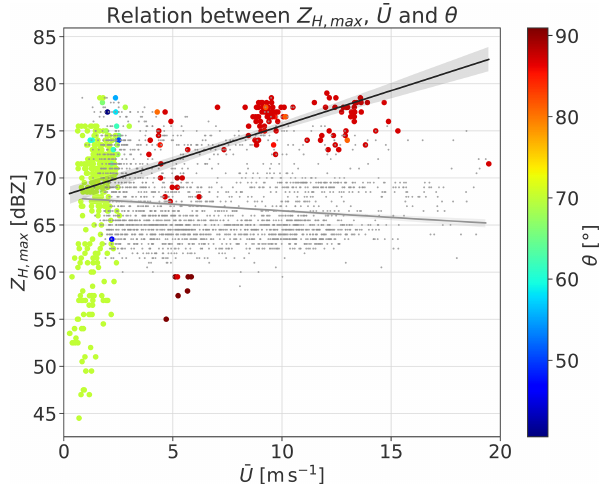
Figure 15. Scatterplots and corresponding linear regression lines with confidence interval sizes of 95% for the regression estimate (translucent bands) showing the relations between the average wind speed ¯ U and two sub-data sets of Z H , max . The data when the rotor speed r s ≥ 1rpm are plotted in gray, while the data for r s < 1rpm are represented by the color-mapped scatter points. The color di- mension shows the blade pitch angle θ . The black regression line belongs to the color-mapped scatter points. The confidence inter- vals are estimated using a bootstrap